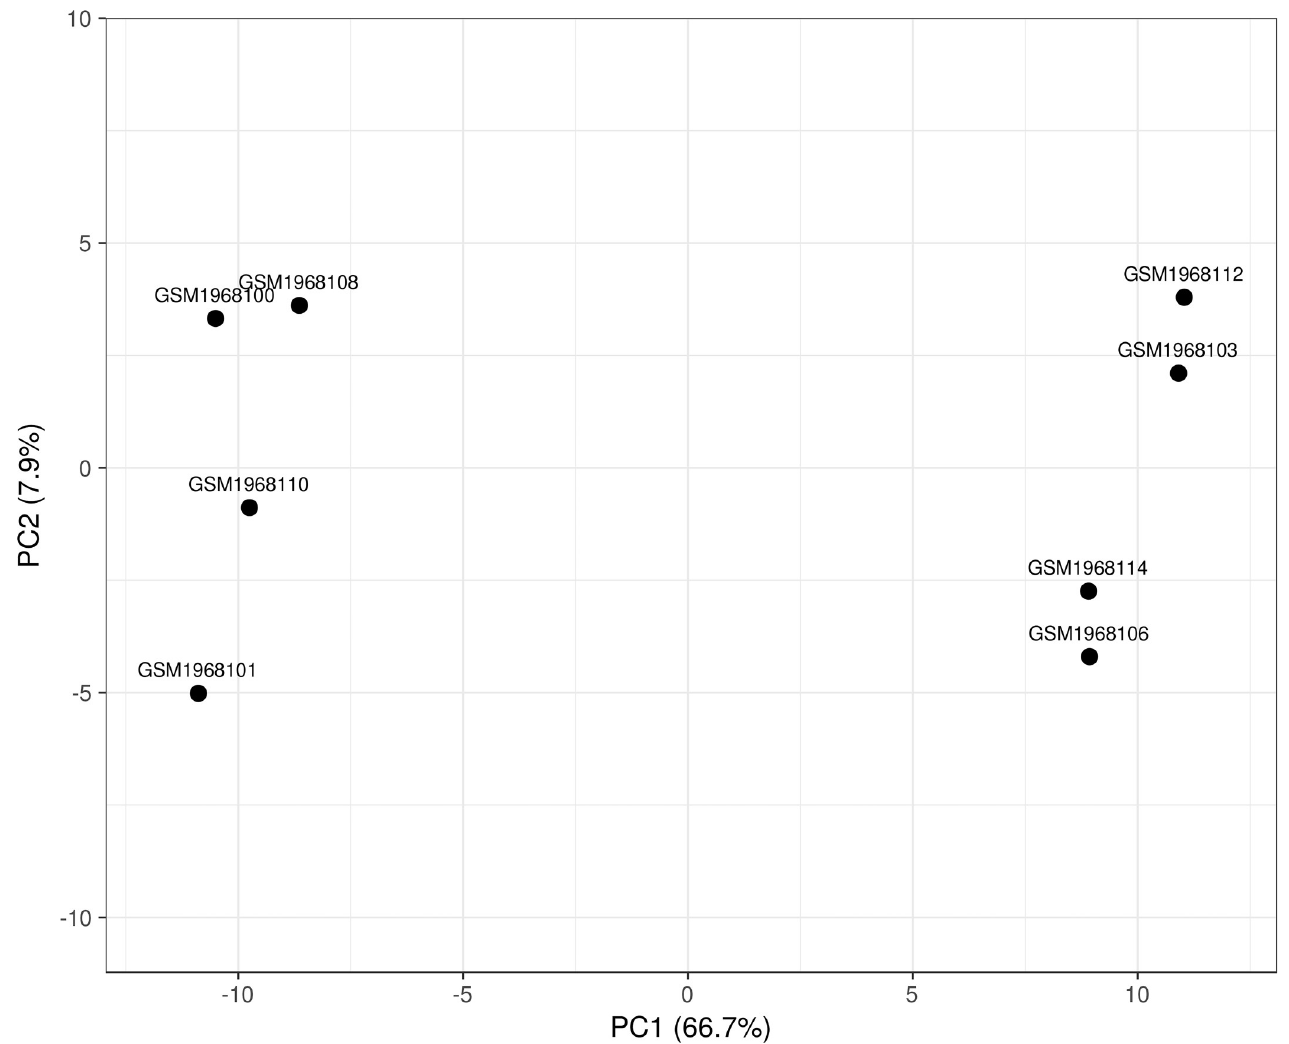
Fig 1. Two-dimensional plot related to the first two principal components. GSM1968101, GSM1968110, GSM1968100 and GSM1968108 are samples related to Mg 2+ supplementation. GSM1968106, GSM1968114, GSM1968103 and GSM1968112 are samples related to Cu 2+